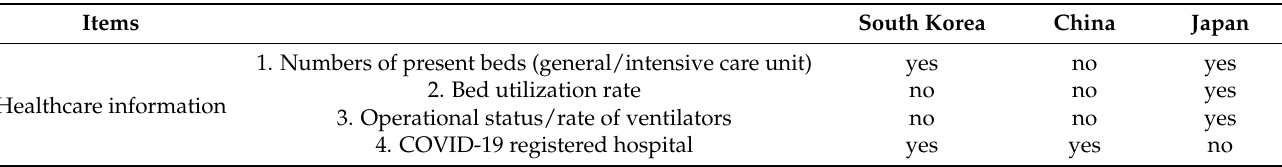
Table 4. Content comparison of “healthcare information” for the COVID-19 dashboard in South Korea, China, and Japan. Items